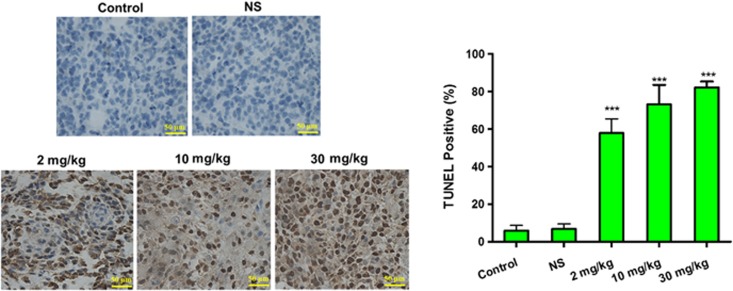
Immunohistochemical analysis of PANC-1 cell xenograft tumor apoptosis. Cells were stained using the TUNEL method and were scored for apoptosis by comparison with the vehicle control. The images on the left illustrate the level of TUNEL staining in the PANC-1 cells comprising the tumor in the control and mogroside V treatment groups. The graphs on the right indicate a mogroside V concentration-dependent increase in TUNEL staining as determined by counting tissue sections from eight independent tumors. For statistical analysis, mogroside V-treated mice were compared with vehicle control mice using Student's t-tests; ***P<0.001 versus the control values.